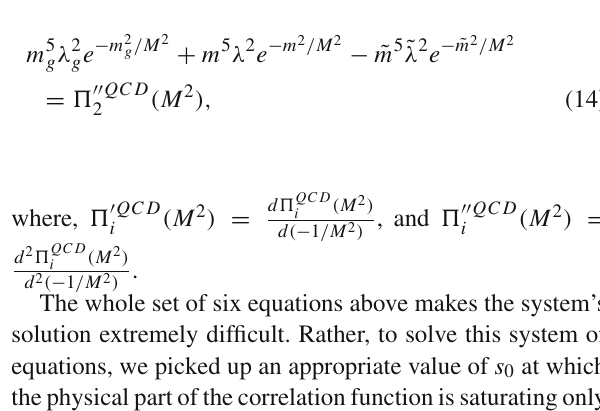
Fig. 3 The dependency of the excited states 2 S , 1 P masses, and pole residues of the doubly-heavy of spin-(3/2) (cid:2) ∗ M 2 at different values of the continuum threshold s